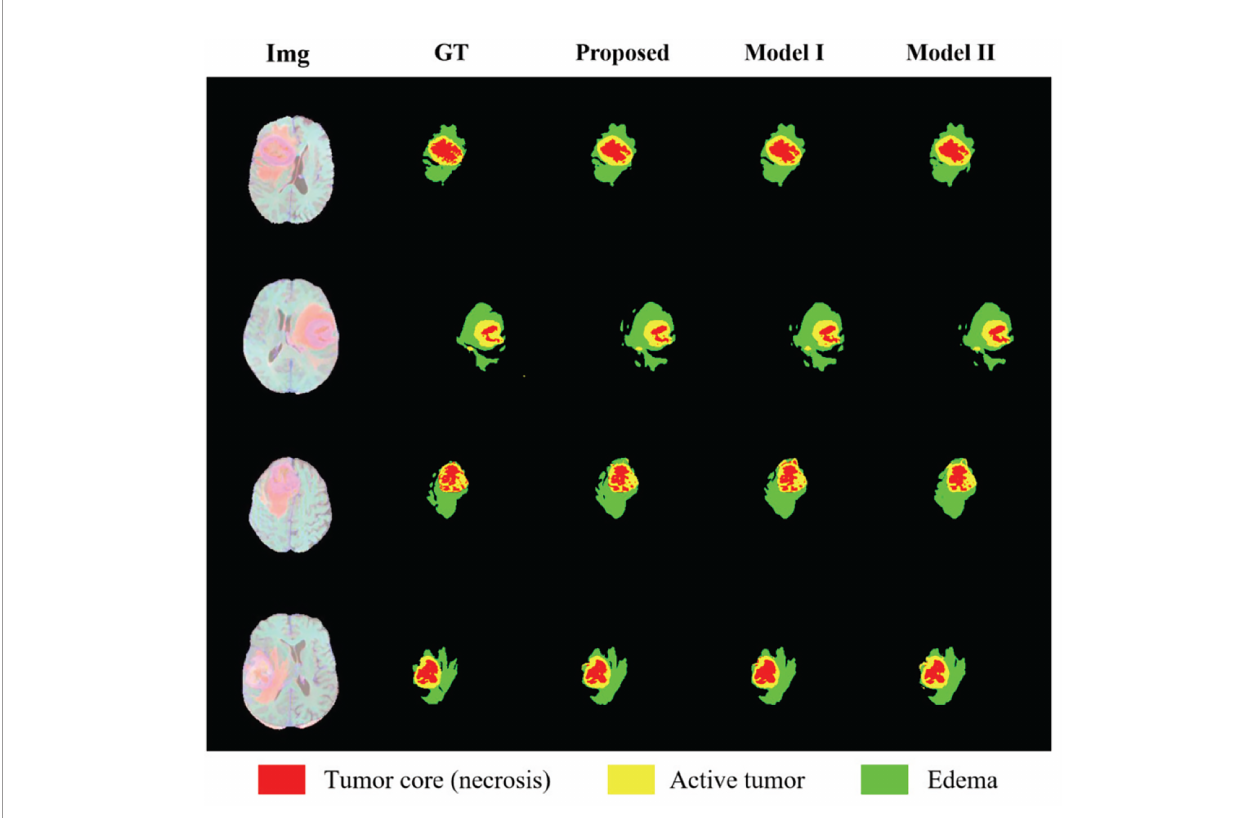
FIGURE 8 | Results of randomly selected examples compared with other model variations. Red color represents the tumor core (necrosis), yellow color represents the active tumor and green regions are the